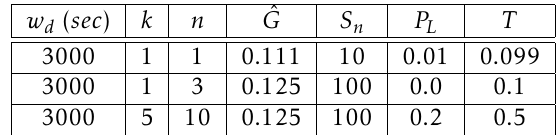
Table 2. Sample data from an observation